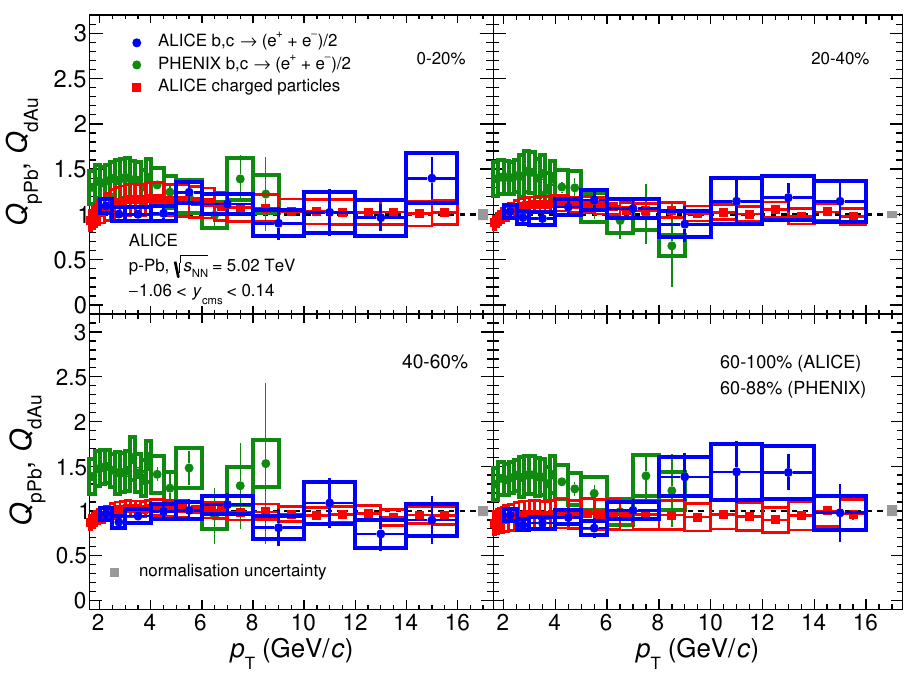
Figure 7 . Nuclear modi(cid:12)cation factors Q pPb as a function of p T in the 0{20%, 20{40%, 40{60%, and 60{100% multiplicity classes selected with the ZNA estimator in p-Pb collisions at 5 : 02 TeV. The di(cid:11)erent panels of the (cid:12)gure are for di(cid:11)erent multiplicity classes. The vertical error bars and the empty boxes represent the statistical and systematic uncertainties, respectively. The solid boxes at high p T at Q pPb = 1 represent the normalisation uncertainties. The results are compared with the PHENIX results on electrons from heavy-(cid:13)avour hadron decays [40] in d+Au p collisions at s NN = 200 GeV and with ALICE charged particle results [44] in p-Pb collisions at p s NN = 5 : 02